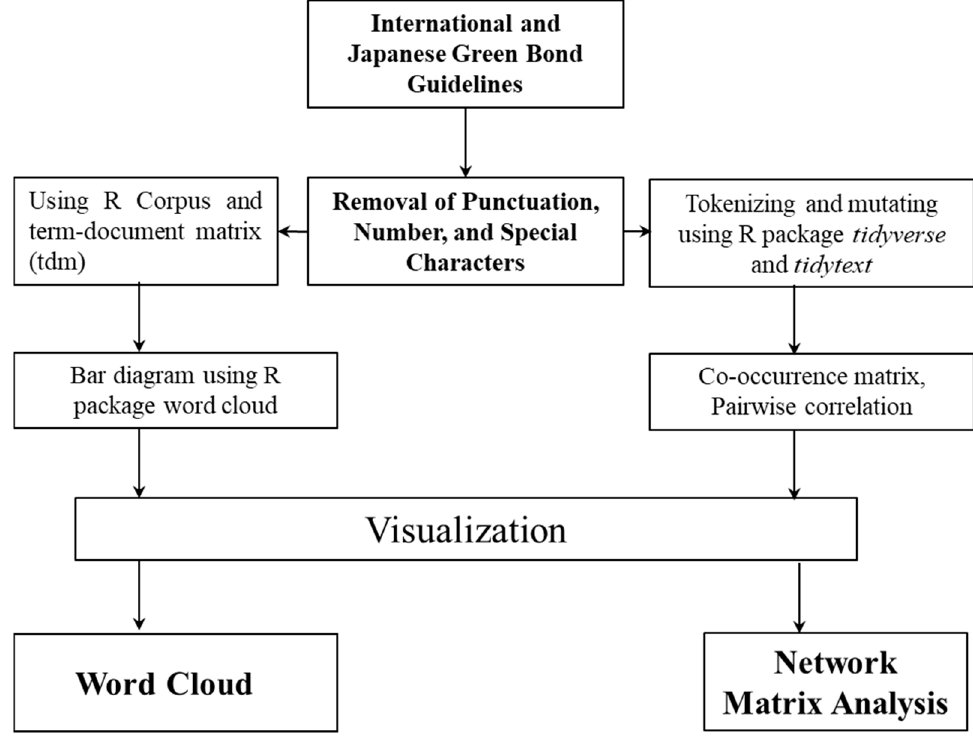
Figure 1. Flowchart of the working procedure .